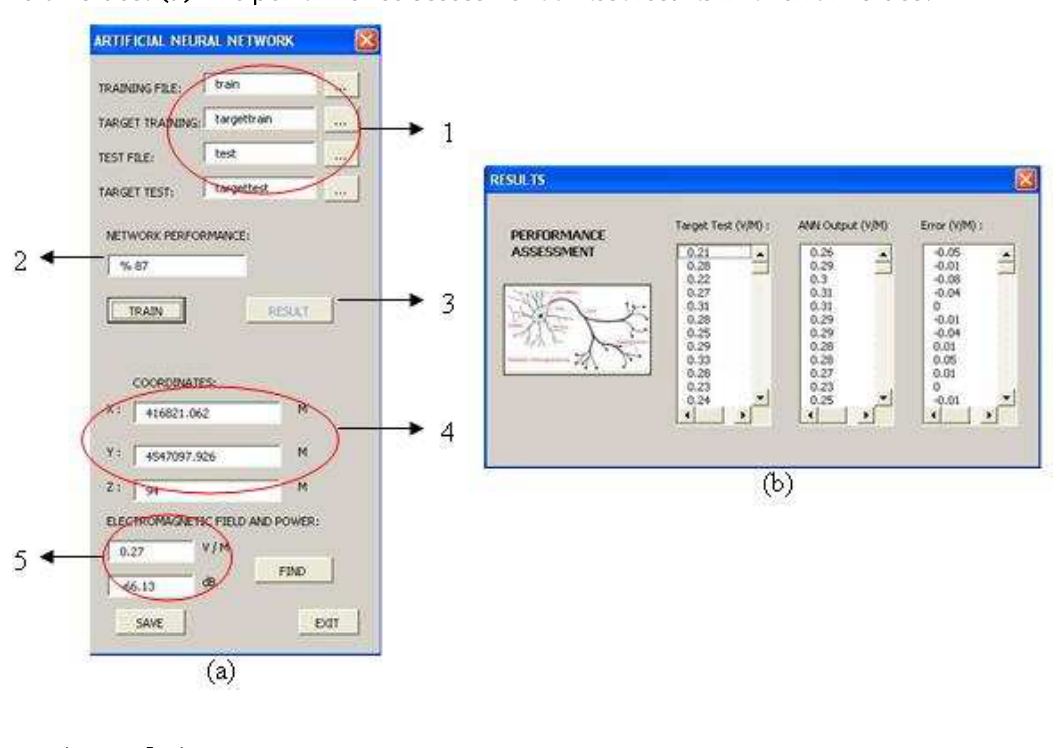
Figure 10. (a) Artificial neural network tool for spatial interpolation of electromagnetic field values. (b) The performance assessment of test results with error